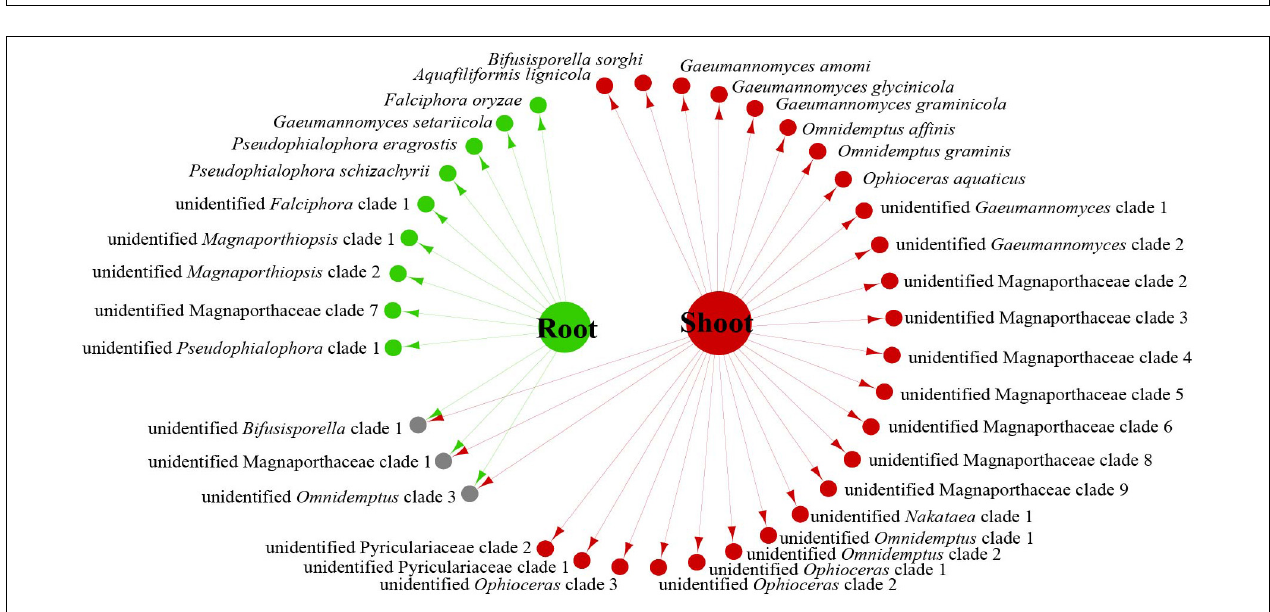
FIGURE 2 | Network of endophytic fungal Magnaporthales species diversity from gramineous plants in Yunnan, Zhejiang, and Inner Mongolia.